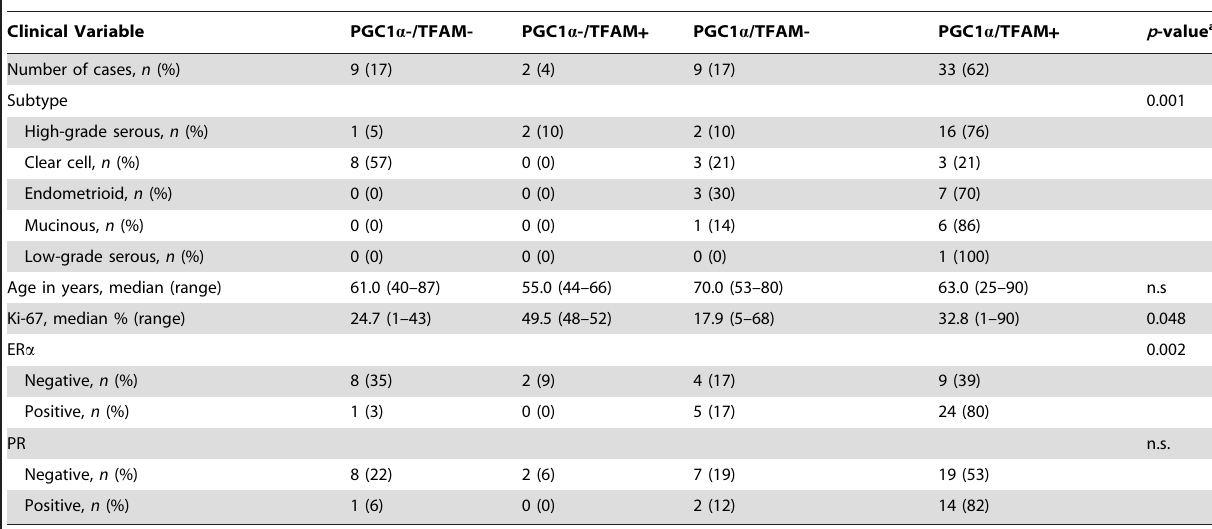
Table 3. Expression status of PGC1 a /TFAM in EOC.